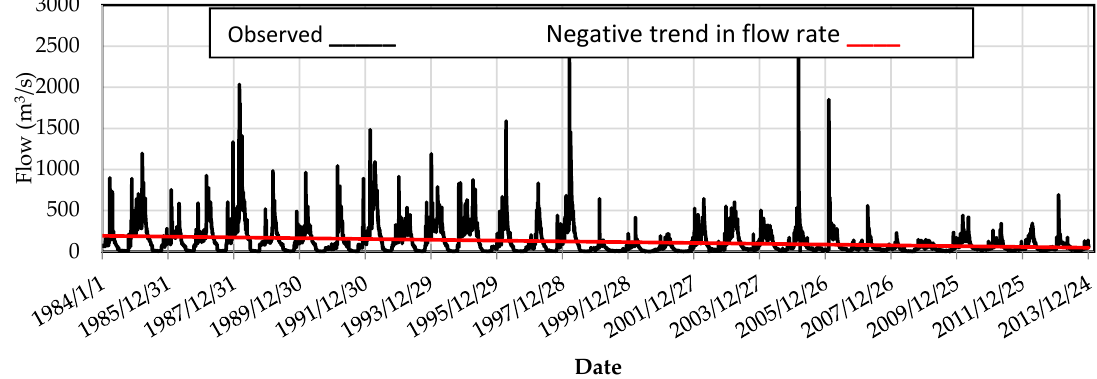
Figure 8. Temporal distribution of the streamflow of the Derbendkhan Watershed for the period from 1984 to 2013.